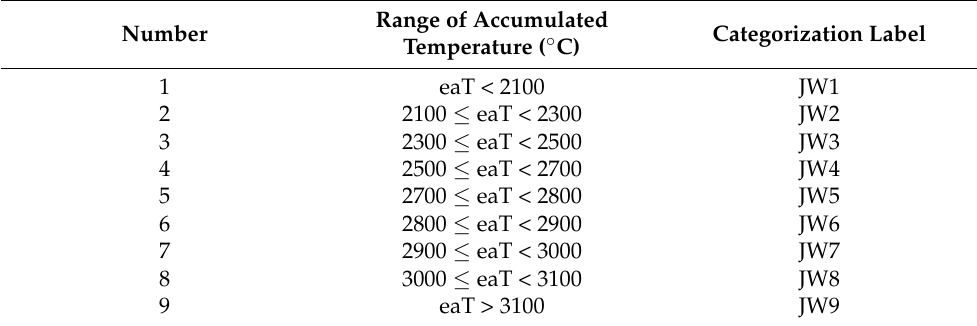
Table 2. Classification of effective accumulated temperature